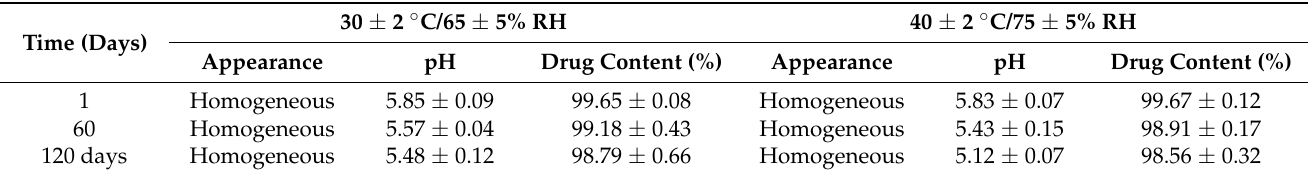
Table 3. Stability studies of AmB + BGEO gel.